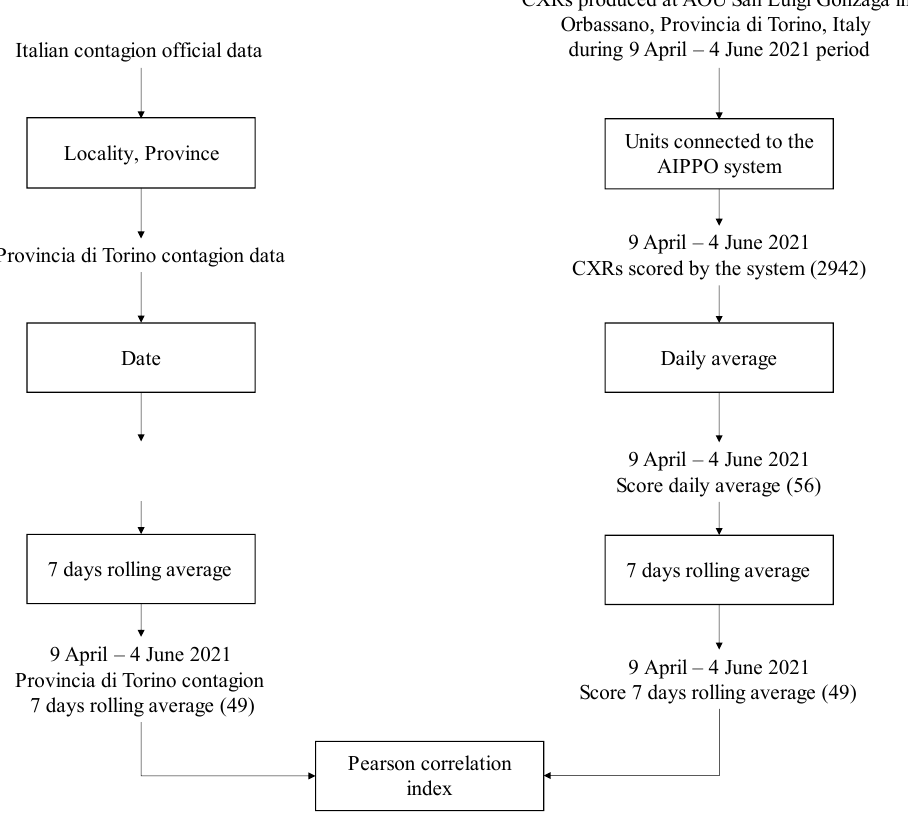
Figure 4. Data selection and elaboration process adopted in phase 2.